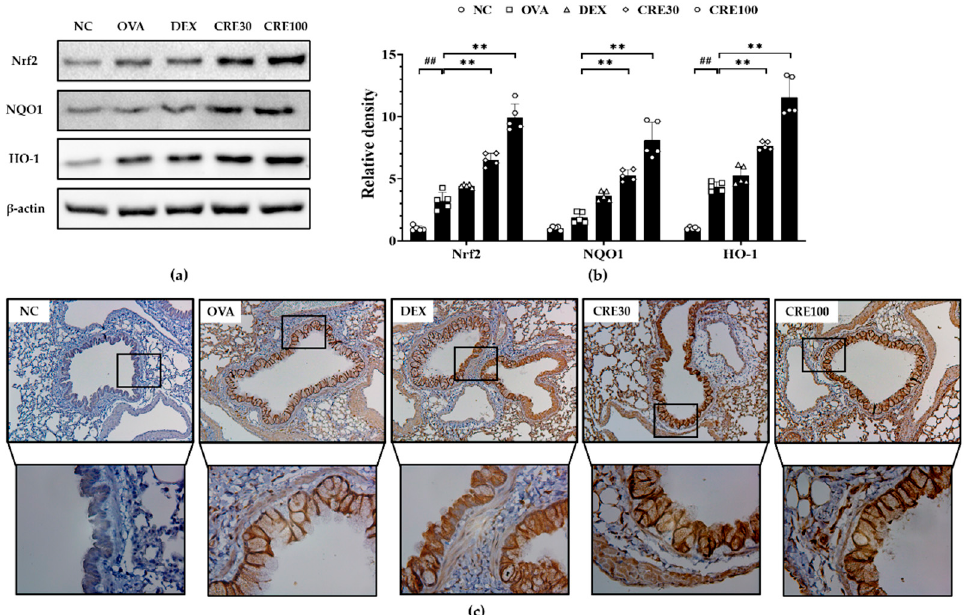
Figure 5. CRE increased the expression of Nrf2/HO-1/NQO1 in animals with asthma. ( a ) The expression of Nrf2/HO-1/NQO1, ( b ) relative expression, ( c ) immunohistochemistry for HO-1. The black box is enlarged and shown in the lower histological figure of (c). NC: PBS treatment and PBS challenge; OVA: PBS treatment and OVA challenge; DEX: dexamethasone (2 mg/kg) treatment and OVA challenge; CRE30 and CRE100: CRE (30 mg/kg and 100 mg/kg, respectively) and OVA challenge. The values are shown as the mean ± SD ( n = 5). ## p < 0.01 versus NC; ** p < 0.01 versus OVA.